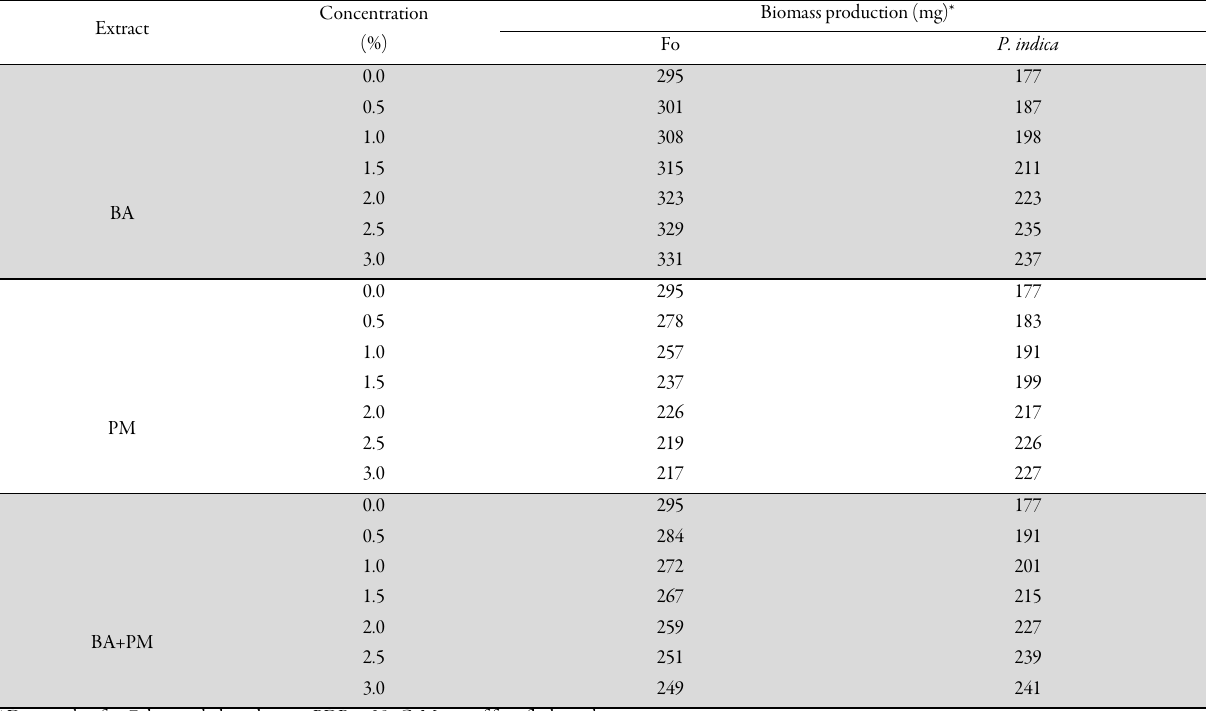
Table 3. Effect of aqueous extracts of BA and PM on biomass production of Fo and P. indica in vitro